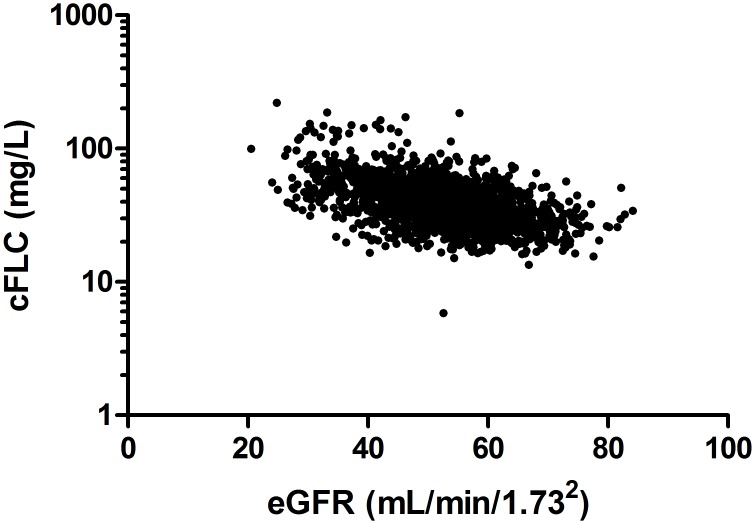
Correlation of cFLC and eGFR.There was a significant inverse association with cFLC (combined serum free light chains) and estimated glomerular filtration rate (eGFR) (rho = -0.49, P <0.0001). Spearman rank correlation was performed.